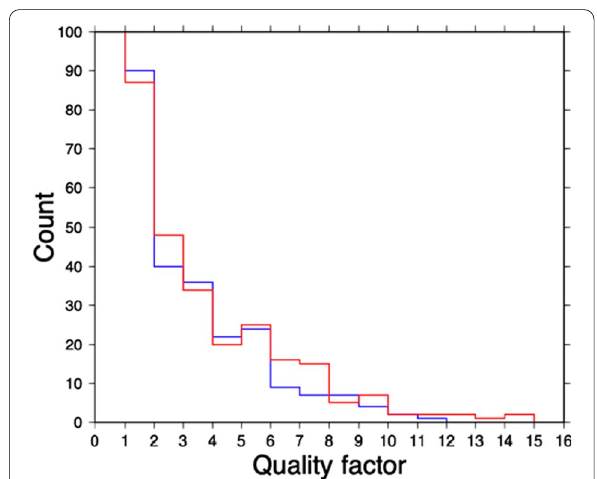
Fig. 5 Improvement on qualify factor of first‑motion focal mechanism determination after 3D‑DD relocation. Blue and red curves show the distribution of qualify factor before and after the